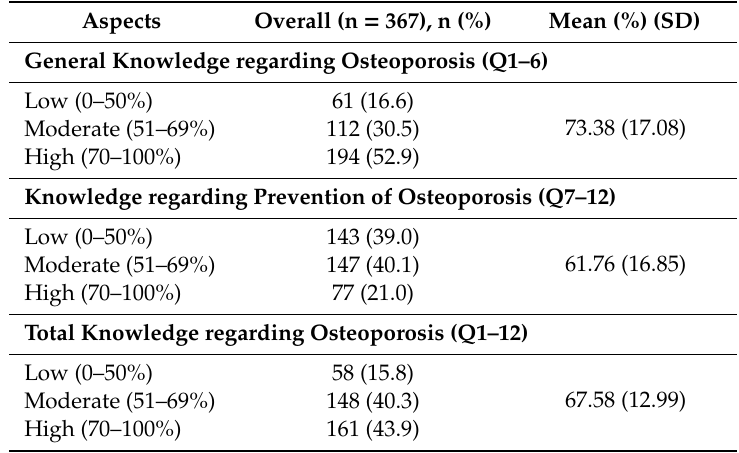
Table 2. Level of knowledge and beliefs towards